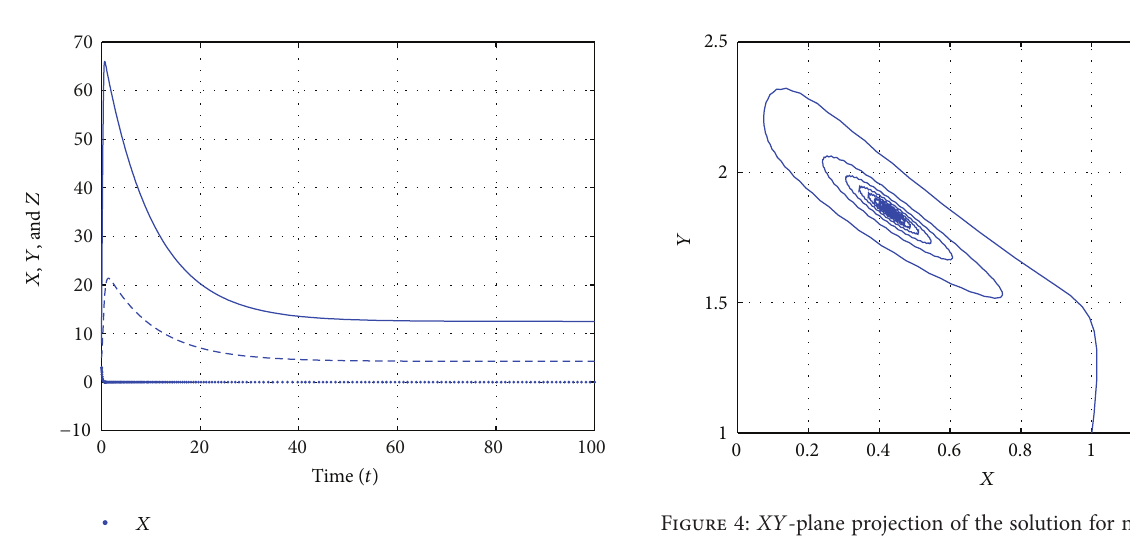
Figure 4: 𝑋𝑌 -plane projection of the solution for nonzero exoge- nous input ( 𝛾 = 1.25 ) with 𝑋(0) = 1 , 𝑌(0) = 1 , and 𝑍(0) = 5 ; parameter values are given in Table 1.